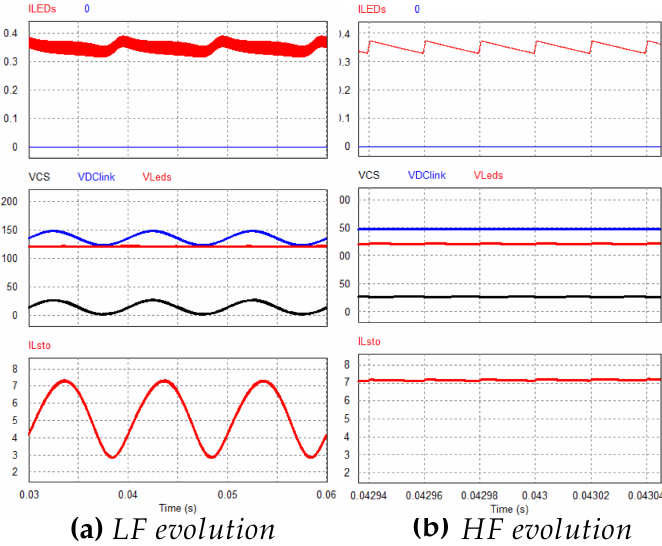
Figure 11. Simulation results for full power operation in closed loop ( L = 300 µ